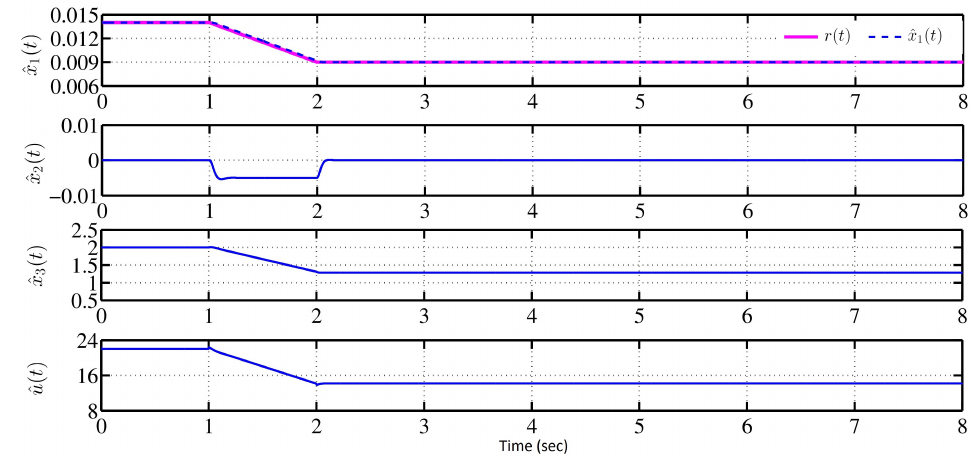
Figure 4. Response of reference model variables driven by the stabilizer without disturbance.